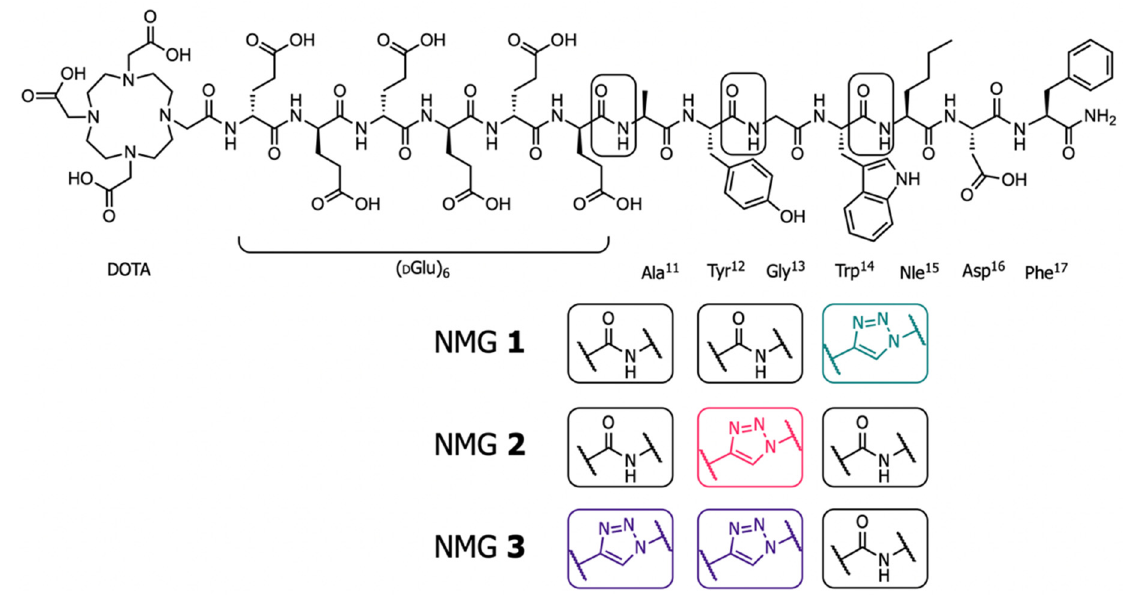
Figure 1. Structure of PP-F11N and NMGs 1 – 3 . The colors of the triazoles correspond to those used in Figures 2–4 indicating the position of the amide-to-triazole substitutions (boxes).